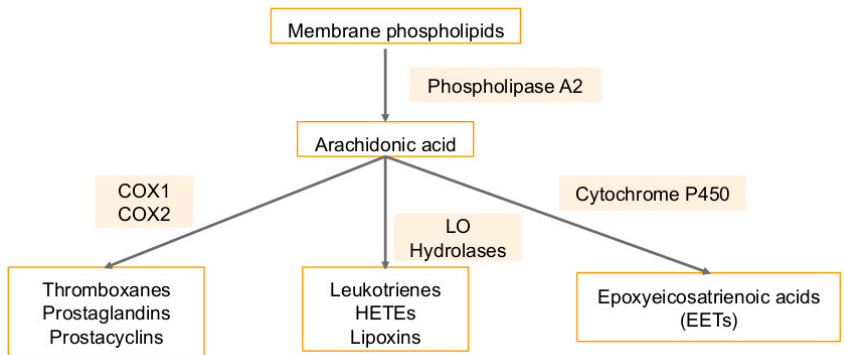
Figure 7. Arachidonic acid cascade: Arachidonic acid is a fatty acid that is freed from cellular membranes by phospholipase A2. It can then be metabolized to prostanoids such as thromboxanes (TXA2), prostacyclin (PGI2) and prostaglandins PGD 2 , PGE 2 , and PGF2a through the cyclooxygenase